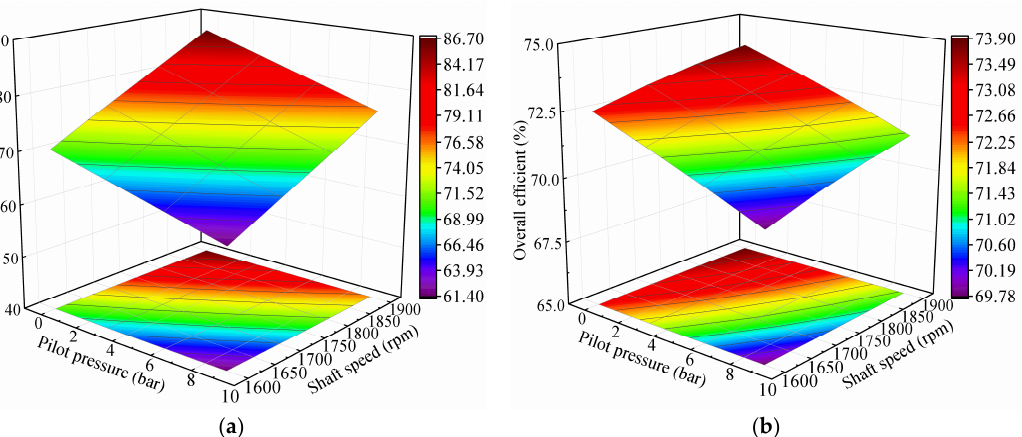
Figure 20. Working stages of the piston chamber: ( a – h ) critical positions between work stages. In stage 1, the piston chamber begins to separate from the oil suction area, the flow area of the piston chamber gradually decreases, and it is completely separated from the oil suction area at position b. In stage 2, the piston chamber enters the closed pre-com- pression pressure zone, and carries out mechanical expansion before crossing the top dead center. Starting from the top dead center, the volume is compressed by mechanical method. The piston chamber is connected to the high-pressure area through the damping hole and the triangular damping groove, and mechanical expansion occurs at the same time, resulting in the oil backflow from the high-pressure area to the piston chamber. In the initial stage, the pressure in the piston chamber is negatively overshoot due to me- chanical expansion. The pre-compression pressure process ends at position c, and there is a positive pressure overshoot at this position, which is mainly caused by mechanical com- pression and oil backflow. Due to oil backflow and pressure overshoot, oil hammer and noise occur in the piston pump. In stage 3, the flow area of the piston chamber increases rapidly, and the pressure of the piston chamber is rapidly balanced with the pressure of the oil discharge area. The piston chamber fully enters the oil discharge area at position d.